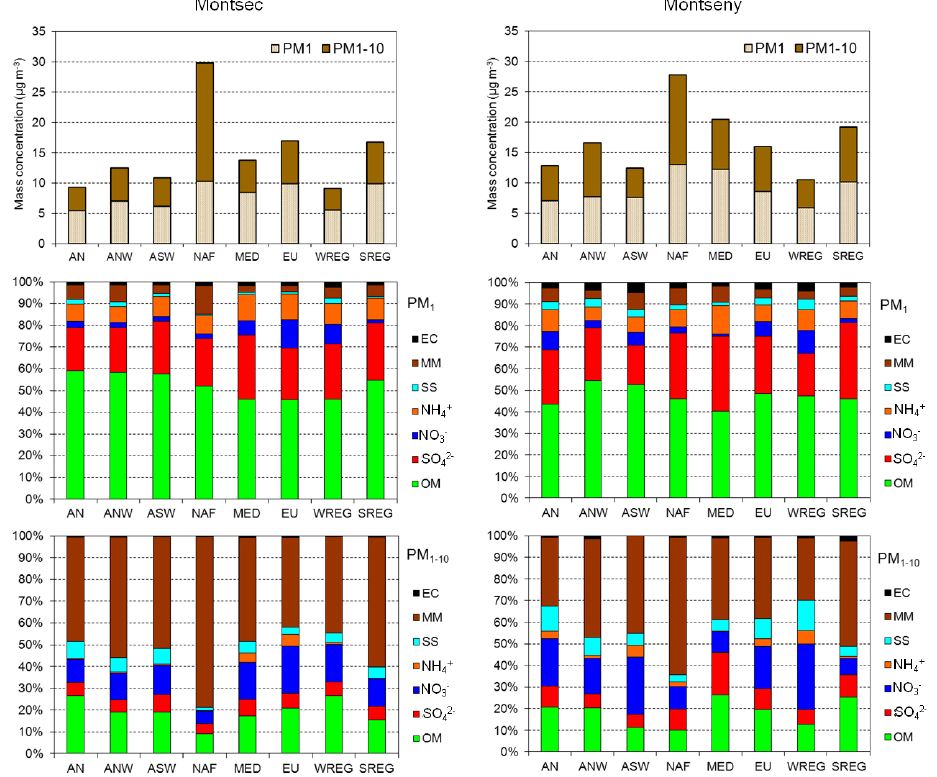
Figure 4. Average concentrations of PM 1 and PM 1 − 10 mass and relative contribution of aerosol major components in PM 1 and PM 1 − 10 fractions for different meteorological episodes at Montsec and Montseny based on daily measurements between January 2010 and March